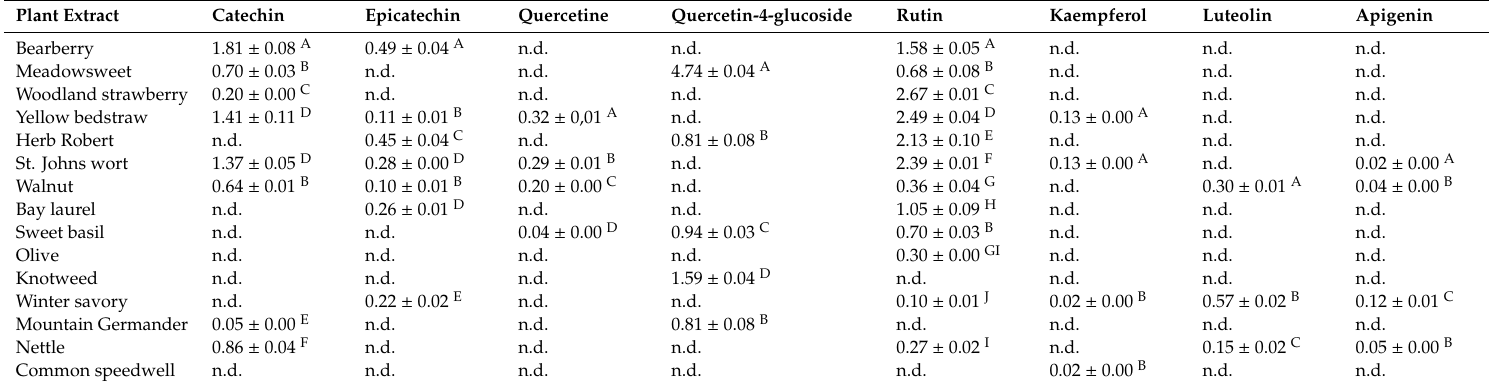
Table 4. Profile of the flavonoids (mg / g) in investigated herb